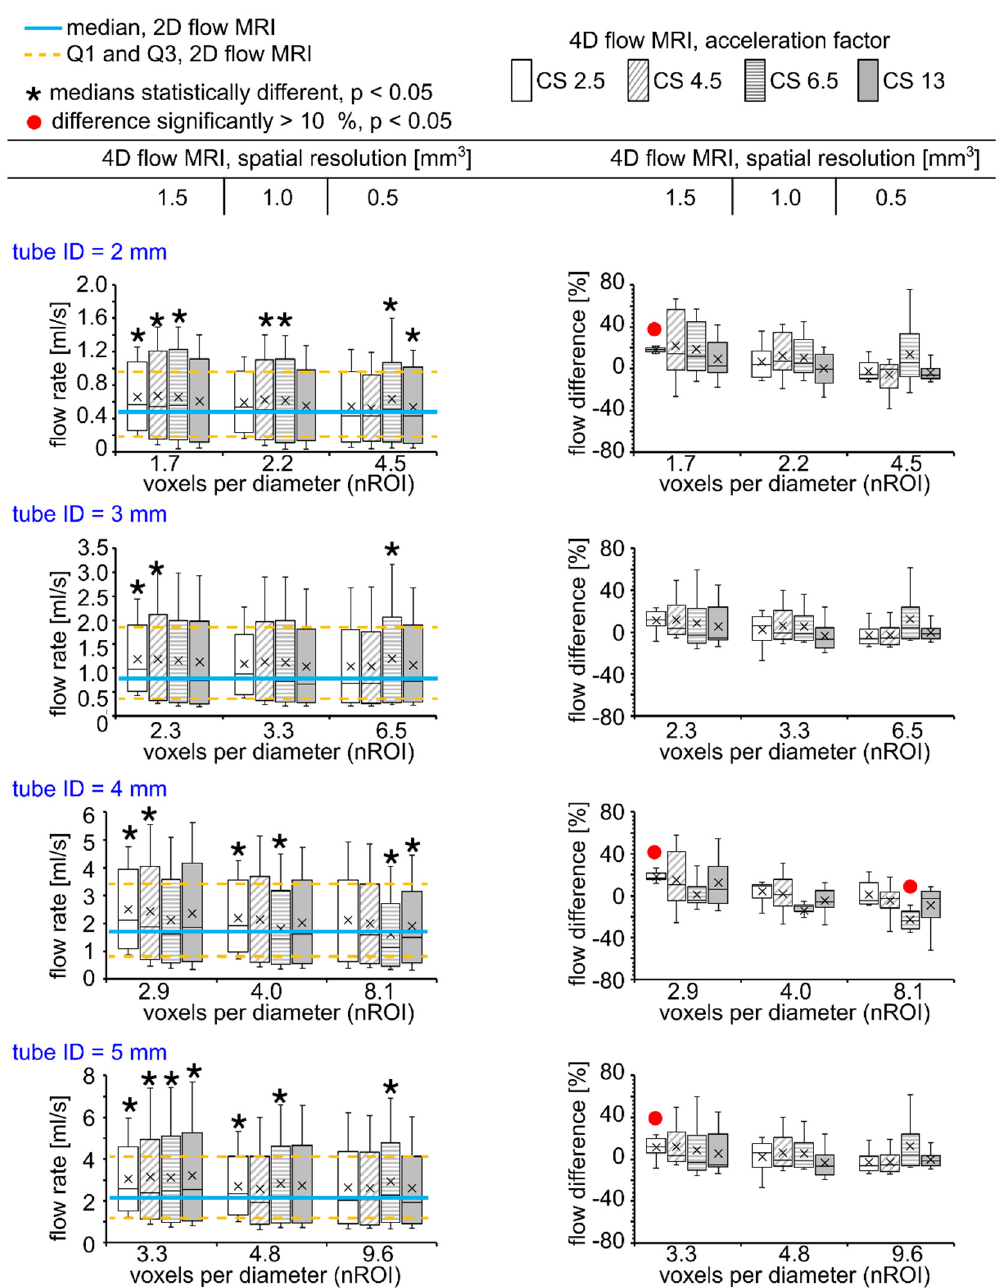
Figure 4. Box plots representing flow values obtained with 4D flow MRI (left) and flow differences calculated between 4D and 2D flow MRI (right). A voxel size of 1.5 mm 3 and CS = 2.5 and 4.5 resulted in statistically different flow median values ( p < 0.001, star sign, left, a two-sided paired Wilcoxon signed-rank test). However, the difference was significantly higher than 10% only for four datasets ( p < 0.001, red circle, right, a two-sided paired Wilcoxon signed-rank test). Flow difference between 4D and 2D flow ranged from –23.75% (tube ID = 4 mm, voxel size = 0.5 mm 3 , CS = 6.5) to +18.31% (tube ID = 2 mm, voxel size = 1.5 mm 3 , CS = 2.5). However, the median of flow difference calculated between 4D and 2D flow MRI was statistically higher than 10% only for voxel size of 1.5 mm 3 and CS = 2.5 for tube ID = 2, 4, and 5 mm ( p < 0.001), and for a voxel size of 0.5 mm 3 and CS = 6.5 for tube ID = 4 mm ( p < 0.001, Figure 4 right). Summary statistics of flow differences for each tube ID, voxel size, and CS factor is summarized in supporting information (Tables S4 and S5).